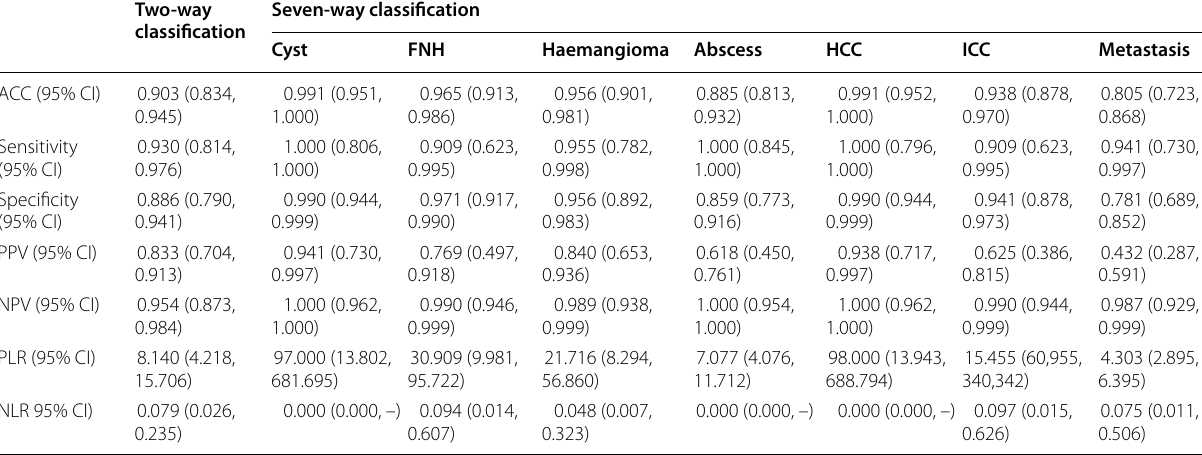
Table 3 Deep learning model diagnostic performance in the two‑way and seven‑way classification on the test